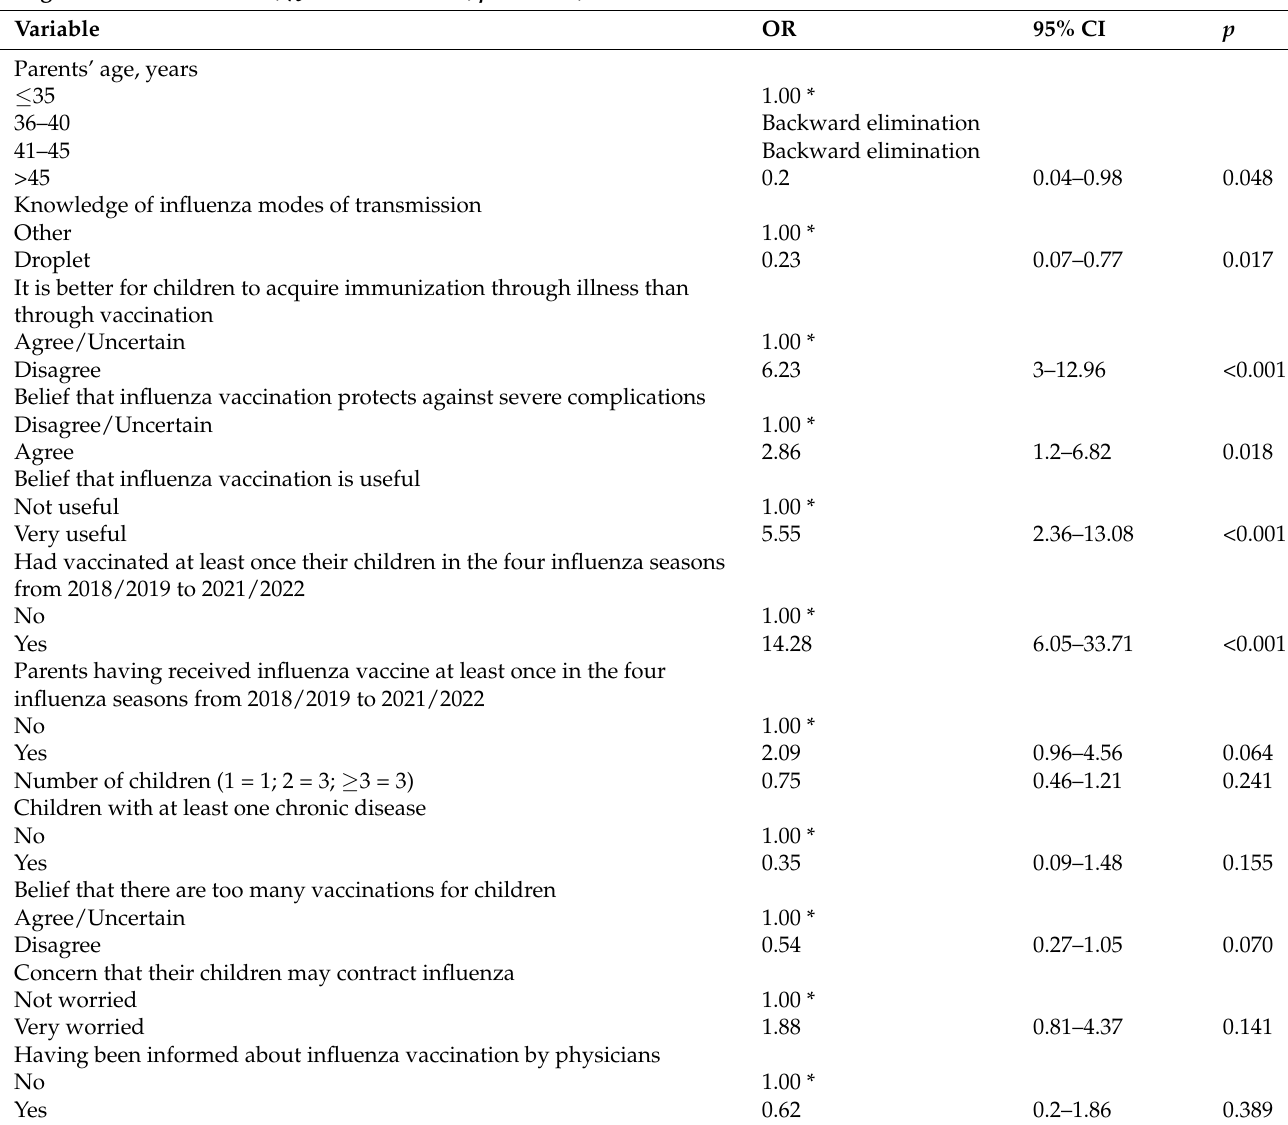
Table 3. Multivariate logistic regression analyses to characterize factors associated with willingness to vaccinate their children in the upcoming 2022/2023 influenza